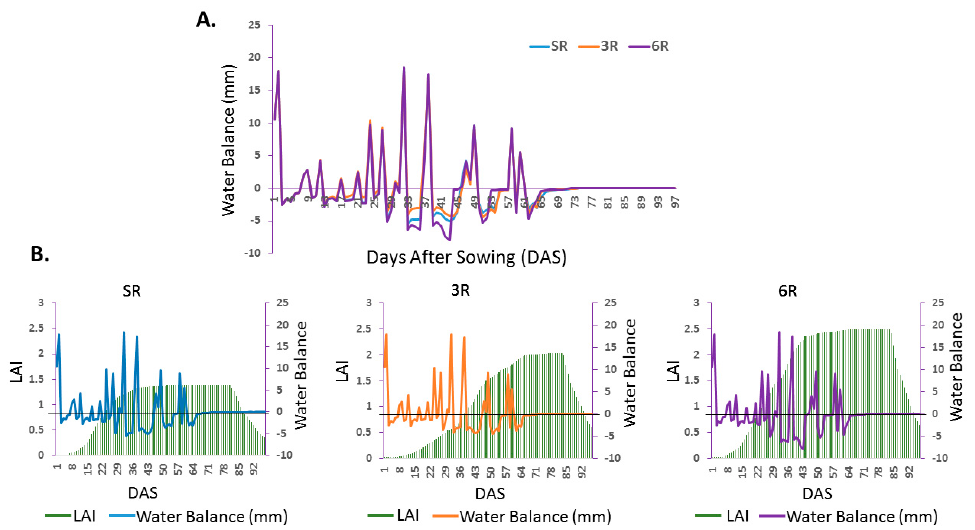
Figure 6. Water balance ( A ) and leaf area index (LAI) ( B ) for 2024 under climatic scenarios RCP4.5 for common bean cultivar Pinto Saltillo (growth habit III) under sowing densities of 90,000 (SR), 145,000 (3R), and 260,000 (6R) plants ha − 1 under rainfed conditions in the semi-arid temperate highland of Pabellon de Arteaga in Aguascalientes, Mexico.